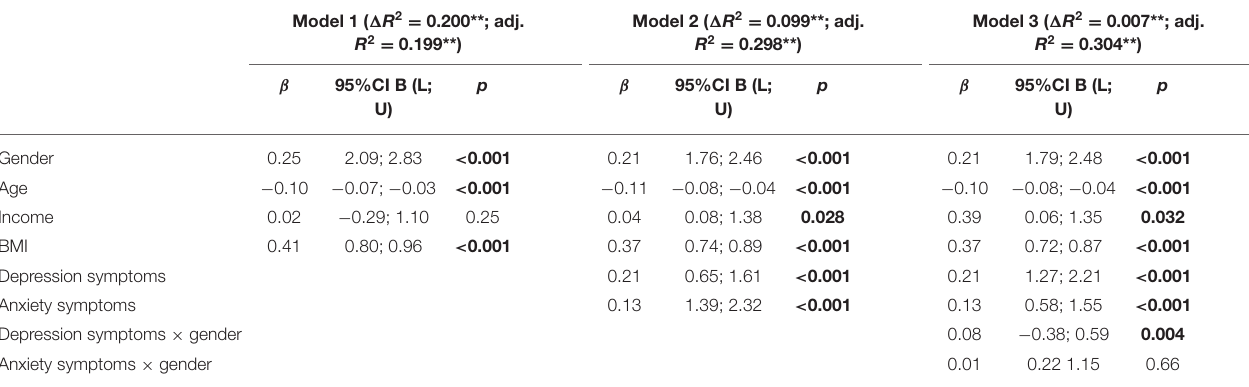
TABLE 2 | Hierarchical linear regression of eating disorder symptoms (dependent variable: EDE-Q8 sum